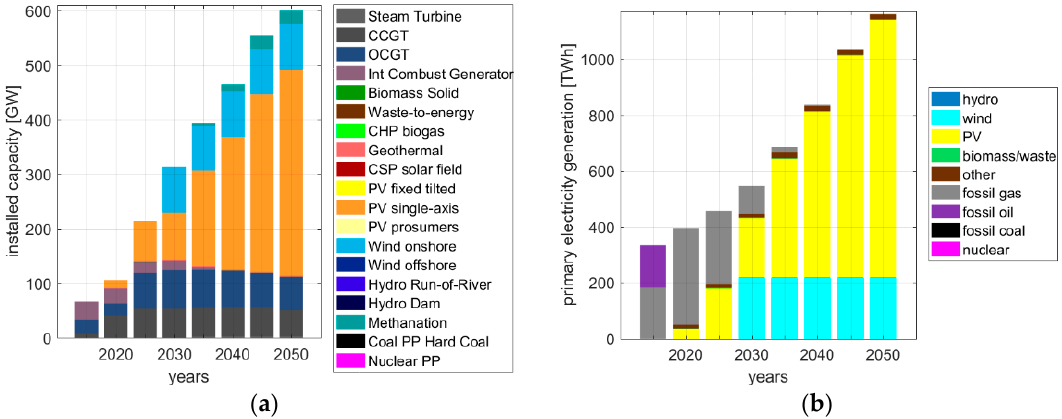
Figure 7. Installed capacities ( a ) and electricity produced ( b ) of the different power plants required from 2015 to 2050.